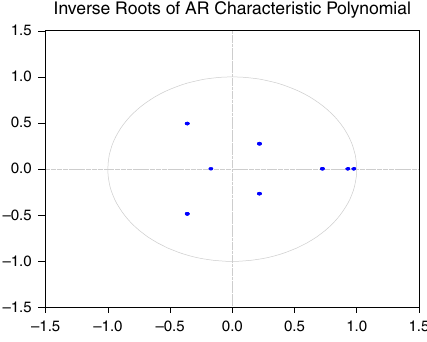
Figure 2. Optimal lag selection criteria under VAR model in polynomial